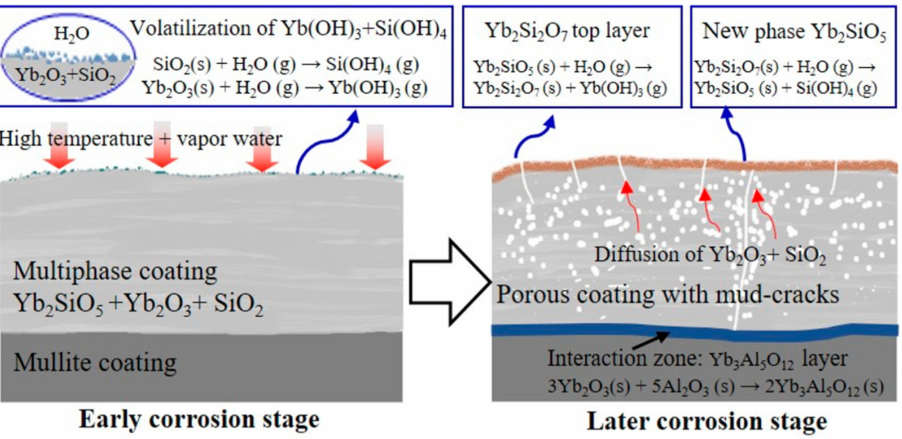
Figure 13. Structural evolution model of vapor corrosion of Yb 2 SiO 5 coating